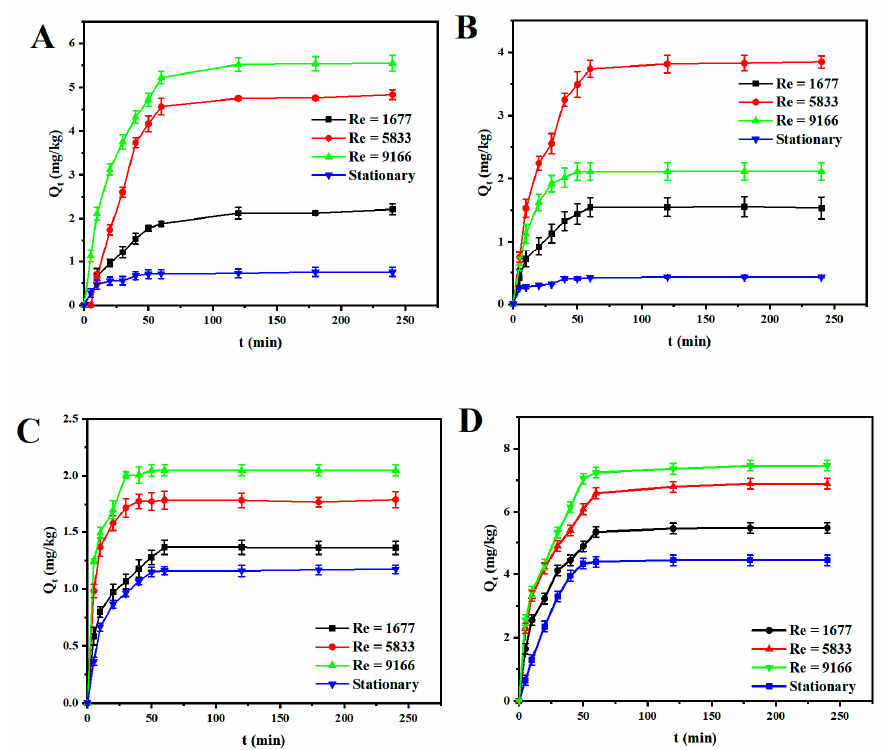
Figure 4. Variation of adsorption amount with time under different regimes on ( A ) 2–3 mm quartz sand ( B ) 250–425 µ m quartz sand ( C ) montmorillonite and ( D ) sediment sample.